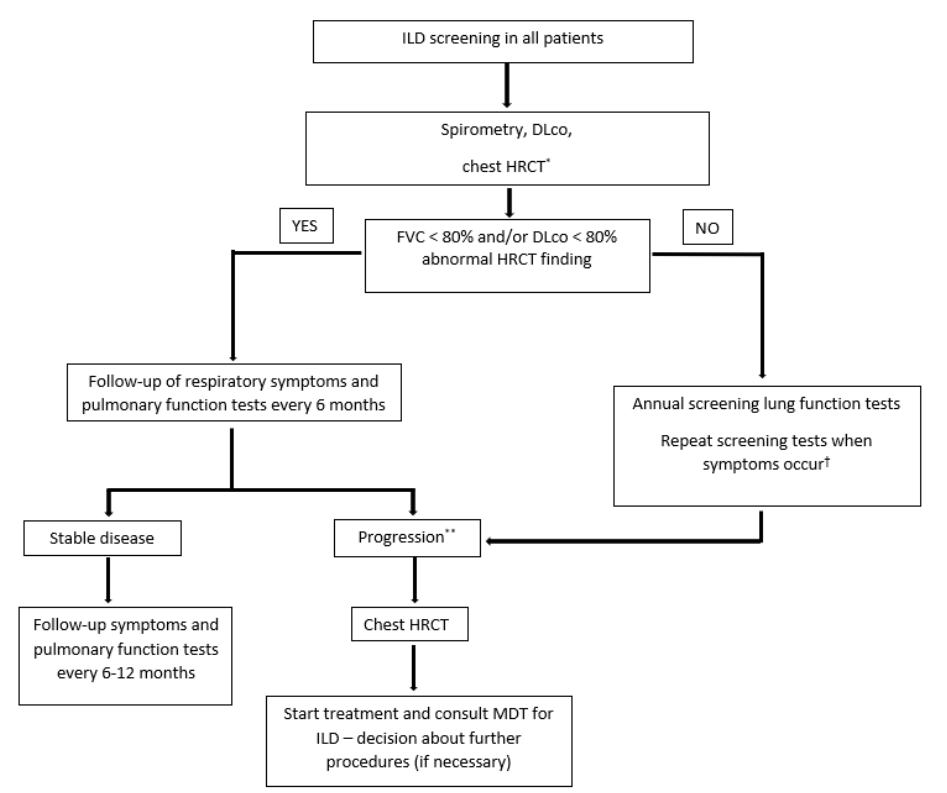
Figure 1. Screening for ILD in newly discovered MCTD, IIM, or SSc patients. Abbreviations: DLco, diffusion capacity for carbon monoxide; FVC, forced vital capacity; HRCT, high-resolution com- puted tomography; IIM, idiopathic inflammatory myopathy; ILD, interstitial lung disease; MCTD, mixed connective tissue disease; MDT; NSIP; SSc, systemic sclerosis. * Especially in patients with antisynthetase positive antibodies and anti-MDA5 in idiopathic inflammatory myopathy and anti- Scl-70/anti-topoisomerase I antibody in SSc. ** Clinical deterioration and/or decrease in FVC or DLco below 80% or by more than 10% compared to previous findings. † Most common symptoms include shortness of breath, exertional dyspnea, dry cough without phlegm, and weakness/extreme fatigue. Other symptoms include loss of appetite, unexplained weight loss, chest discomfort, dyspnea, tach- ypnea, and pulmonary hemorrhage.